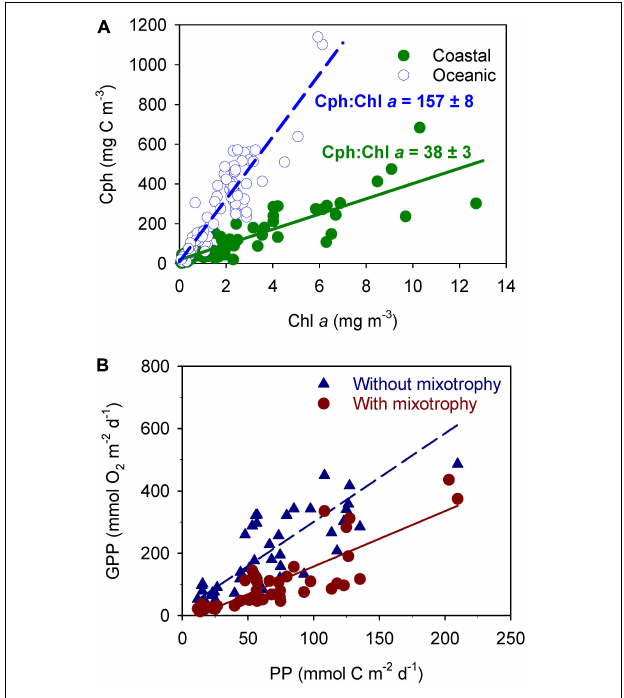
FIGURE 2 | (A) Phytoplankton carbon to chlorophyll a relationships (Cph:Chl a ) at the oceanic and costal domains identified in Figure 1 . (B) Relationship between gross primary production estimated from 14 C uptake (PP) and gross primary production predicted following the metabolic theory of ecology (GPP) without considering mixotrophy (blue triangles) and considering mixotrophy (brown circles) in nanophytoplankton at the station sampled on the continental shelf of NW Iberia from May 2001 to April 2002. Without correction for mixotrophy (blue dashed line) the relationship is: Y = (17.6 ± 22.6) + (2.83 ± 0.27)X; r 2 = 0.71; n = 46; P < 0.001. Considering 76% of mixotrophy in nanophytoplankton (continuous brown line) the relationship is: Y = (–20.0 ± 14.1) + (1.78 ± 0.17)X; r 2 = 0.71; n = 46; P < 0.001. (A) Adapted from Crespo et al. (2011) and (B) from Figueiras et al.